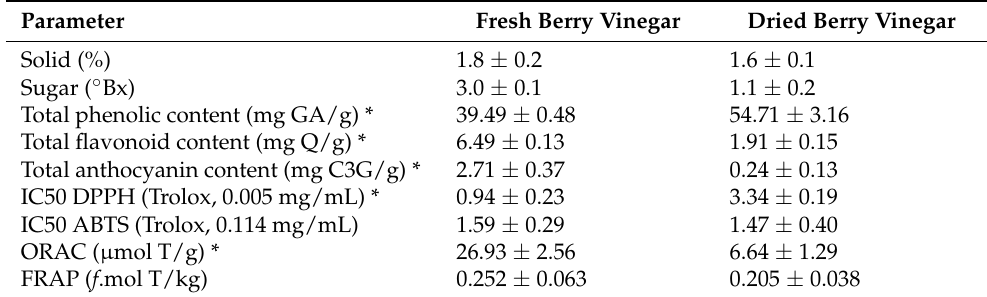
Table 4. Phytochemical content and antioxidant capacity of jaboticaba vinegar fermented from fresh and dried